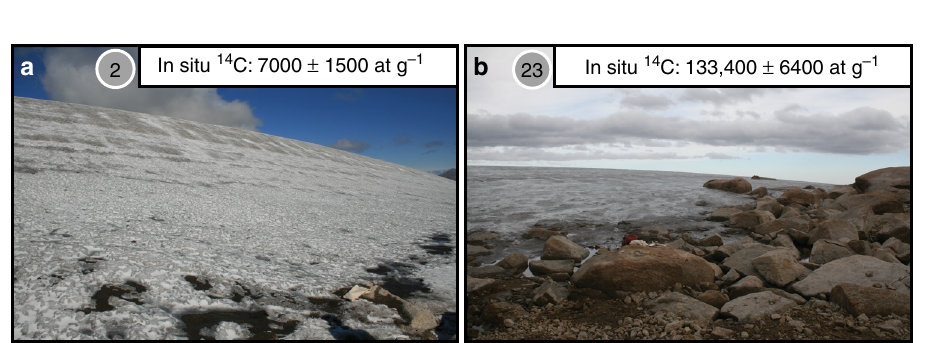
Fig. 2 In situ 14 C sample sites. Photographs of the a lowest (site #2) and b highest (site #23) inventories of in situ 14 C sample locations and measured in situ 14 C concentrations. High levels of in situ 14 C production through the thin ice at site #23 relative to thick ice at site #2 likely explains the high in situ